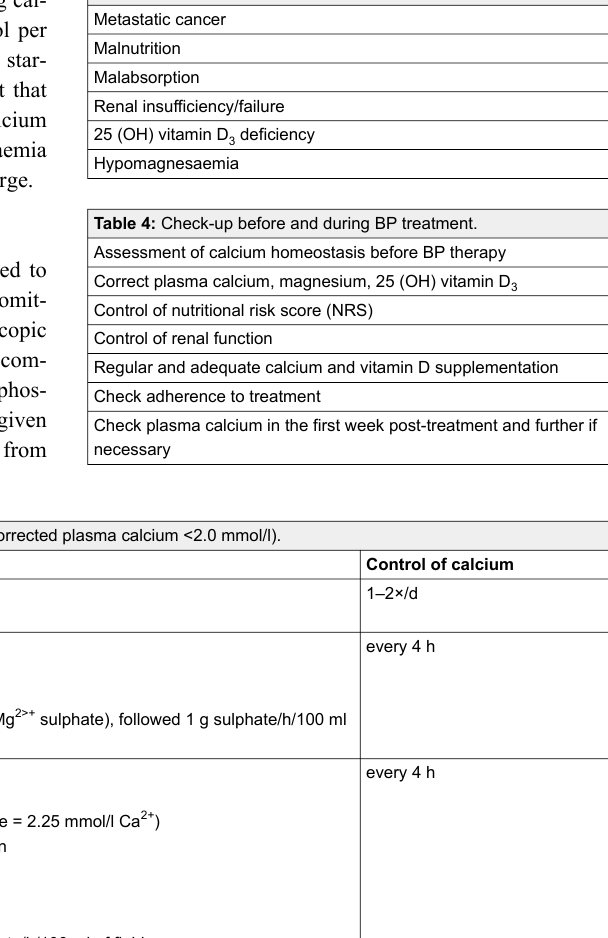
Table 3: Risk factors contributing to BP-induced hypocalcemia.